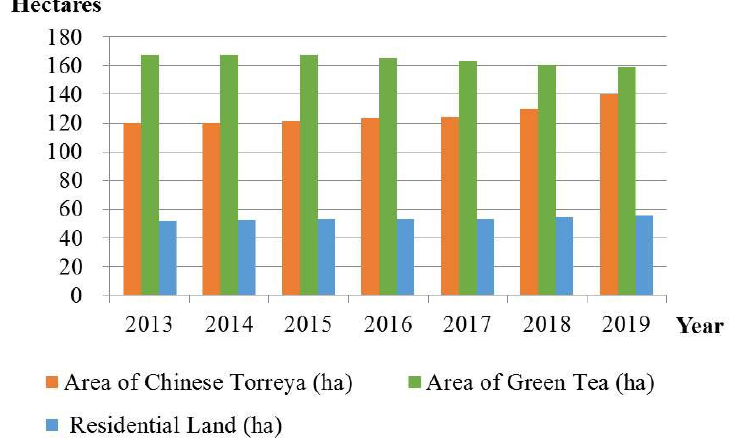
Figure 8. Change in the areas of Chinese Torreya, green tea and living area in Baiyankeng